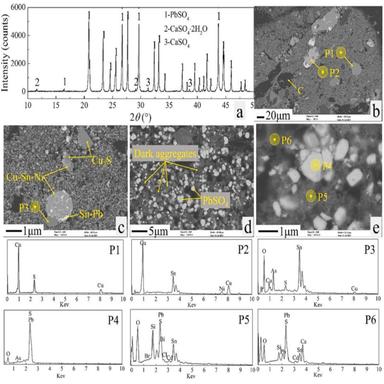
(a) XRD patterns of water leaching residue and (b-e) SEM-EDS images of representative phases; X-ray energy spectrum P1 is for Cu2S, P2 for Cu-sn-Ni alloys, P3 for SnO2 containing As, P4 for PbSO4 containing As, P5 for amorphous silicate containing Sn, Bi, Cd, Cl, and Br, and P6 for the aggregates of amorphous silicic acid, PbSO4, and CaSO4.